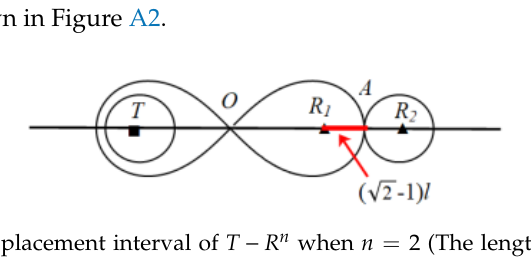
R . By the placement 1